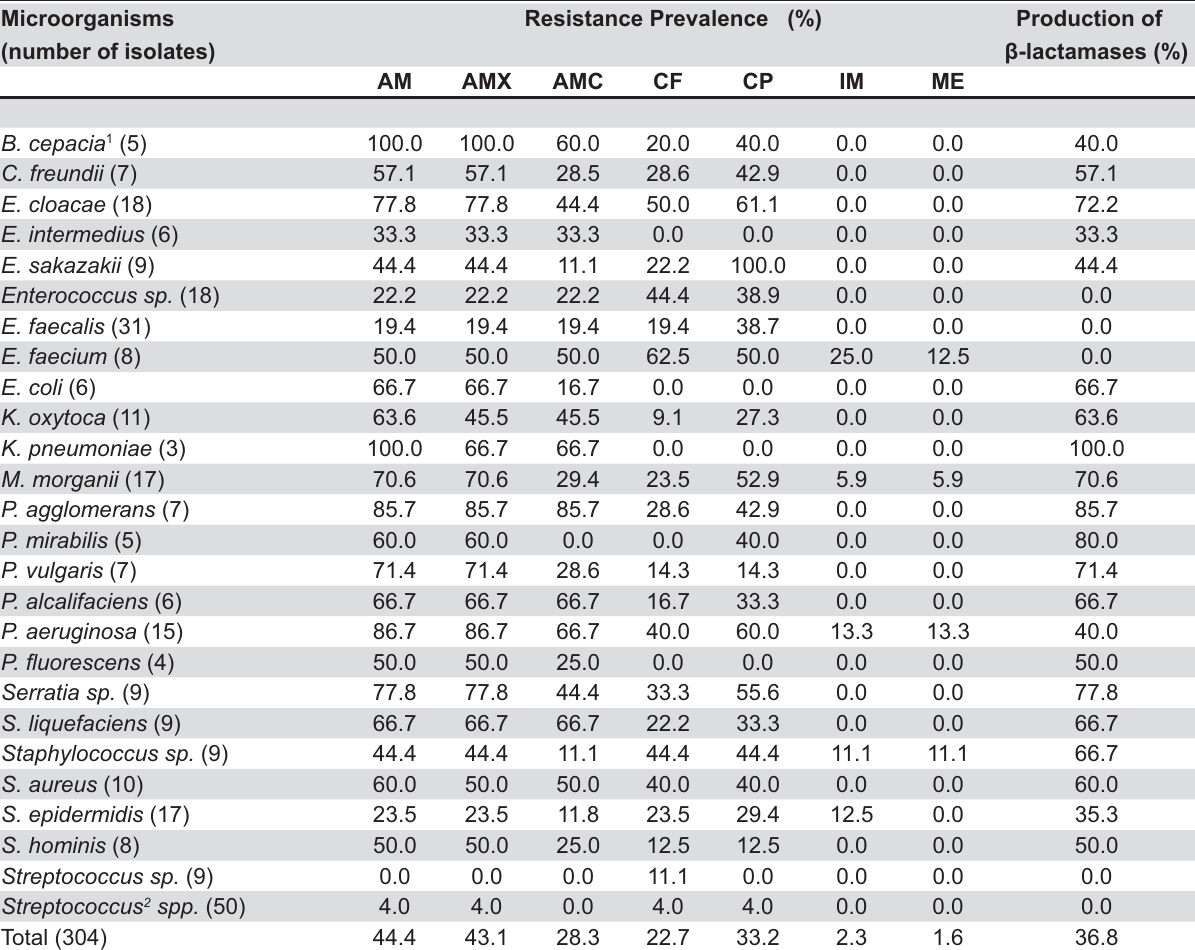
Table 2- (cid:2)(cid:3)(cid:4)(cid:5)(cid:6)(cid:5)(cid:7)(cid:8)(cid:9)(cid:10)(cid:4)(cid:2)(cid:7)(cid:11)(cid:2)(cid:12)(cid:13)(cid:14)(cid:8)(cid:10)(cid:7)(cid:8)(cid:15)(cid:5)(cid:2)(cid:11)(cid:16)(cid:2)(cid:8)(cid:4)(cid:17)(cid:11)(cid:18)(cid:4)(cid:5)(cid:2)(cid:8)(cid:9)(cid:19)(cid:2)(cid:16)(cid:8)(cid:10)(cid:20)(cid:14)(cid:7)(cid:8)(cid:7)(cid:6)(cid:21)(cid:4)(cid:2)(cid:8)(cid:9)(cid:8)(cid:4)(cid:17)(cid:11)(cid:18)(cid:4)(cid:5)(cid:2)(cid:6)(cid:5)(cid:11)(cid:14)(cid:8)(cid:7)(cid:4)(cid:19)(cid:2)(cid:16)(cid:17)(cid:11)(cid:15)(cid:2)(cid:11)(cid:17)(cid:8)(cid:14)(cid:2)(cid:10)(cid:8)(cid:21)(cid:6)(cid:7)(cid:22)(cid:2)(cid:11)(cid:16)(cid:2)(cid:23)(cid:8)(cid:7)(cid:6)(cid:4)(cid:9)(cid:7)(cid:5)(cid:2)(cid:24)(cid:4)(cid:8)(cid:17)(cid:6)(cid:9)(cid:25)(cid:2)(cid:10)(cid:11)(cid:15)(cid:23)(cid:14)(cid:4)(cid:7)(cid:4)(cid:2) denture as well as gingivitis and periodontitis